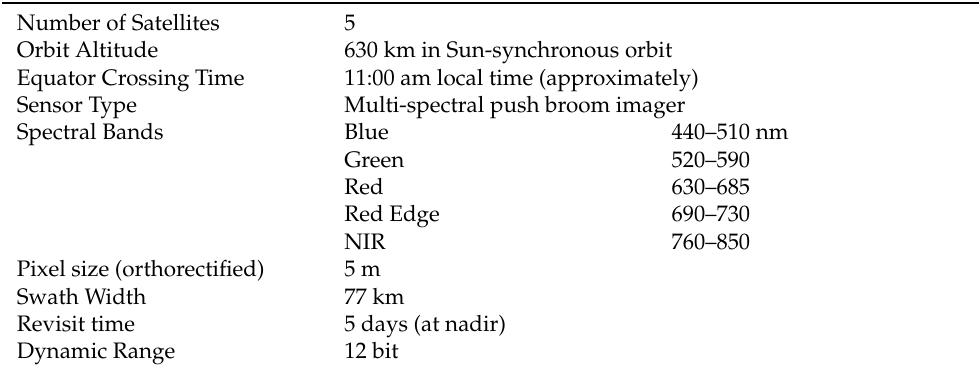
Table A2. RapidEye imager